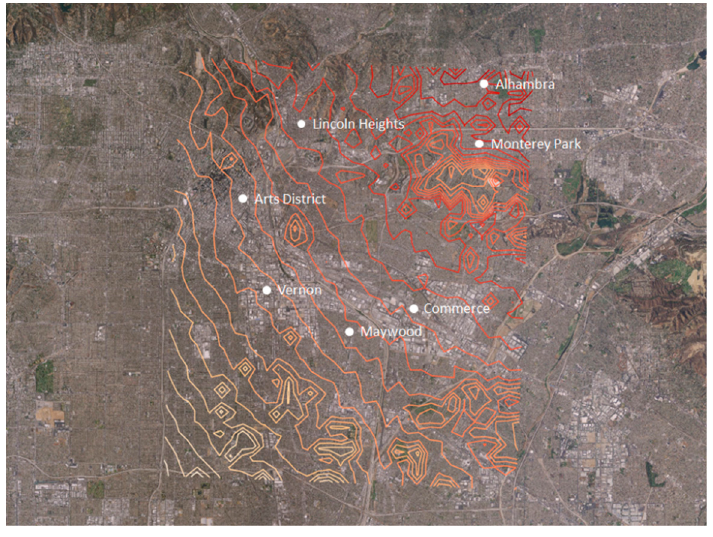
Figure 4. Total DH for interval 1 in the downtown area 500-m domain. The unlabeled contours are only meant to show the spatial pattern of the temperature field.